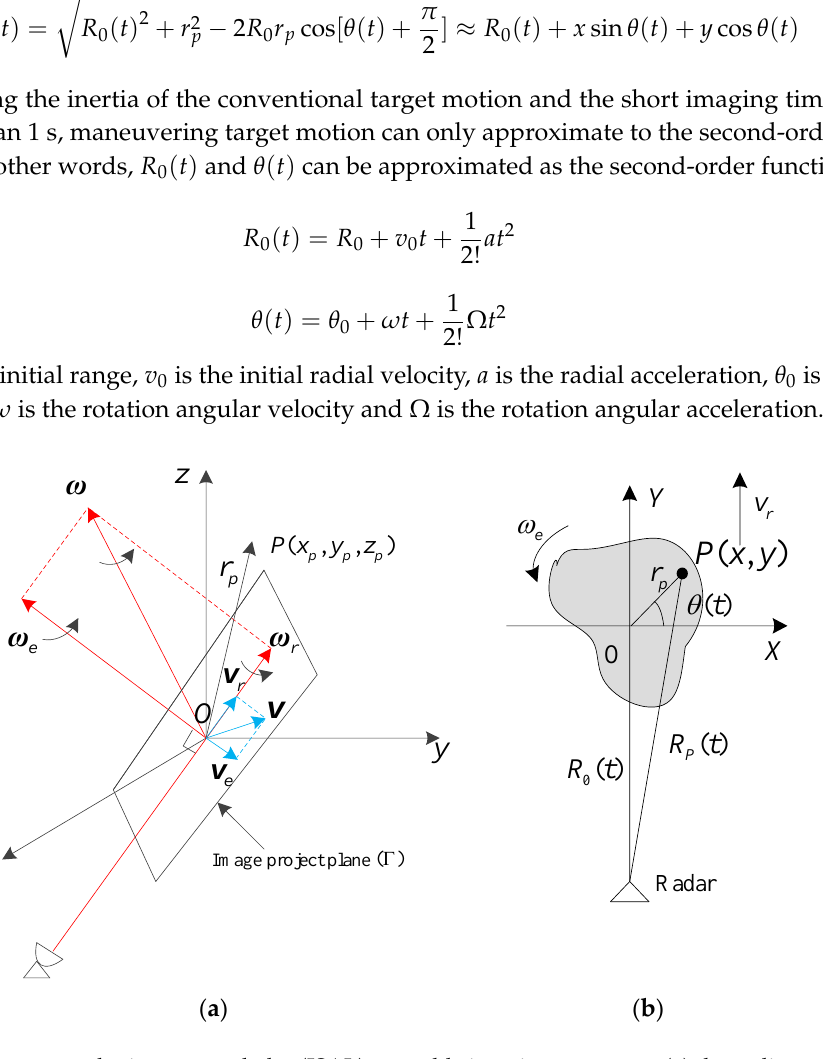
Figure 1. Inverse synthetic aperture ladar (ISAL) turntable imaging geometry; ( a ) three-dimensional (3D) imaging geometry; ( b ) two-dimensional (2D) imaging geometry.